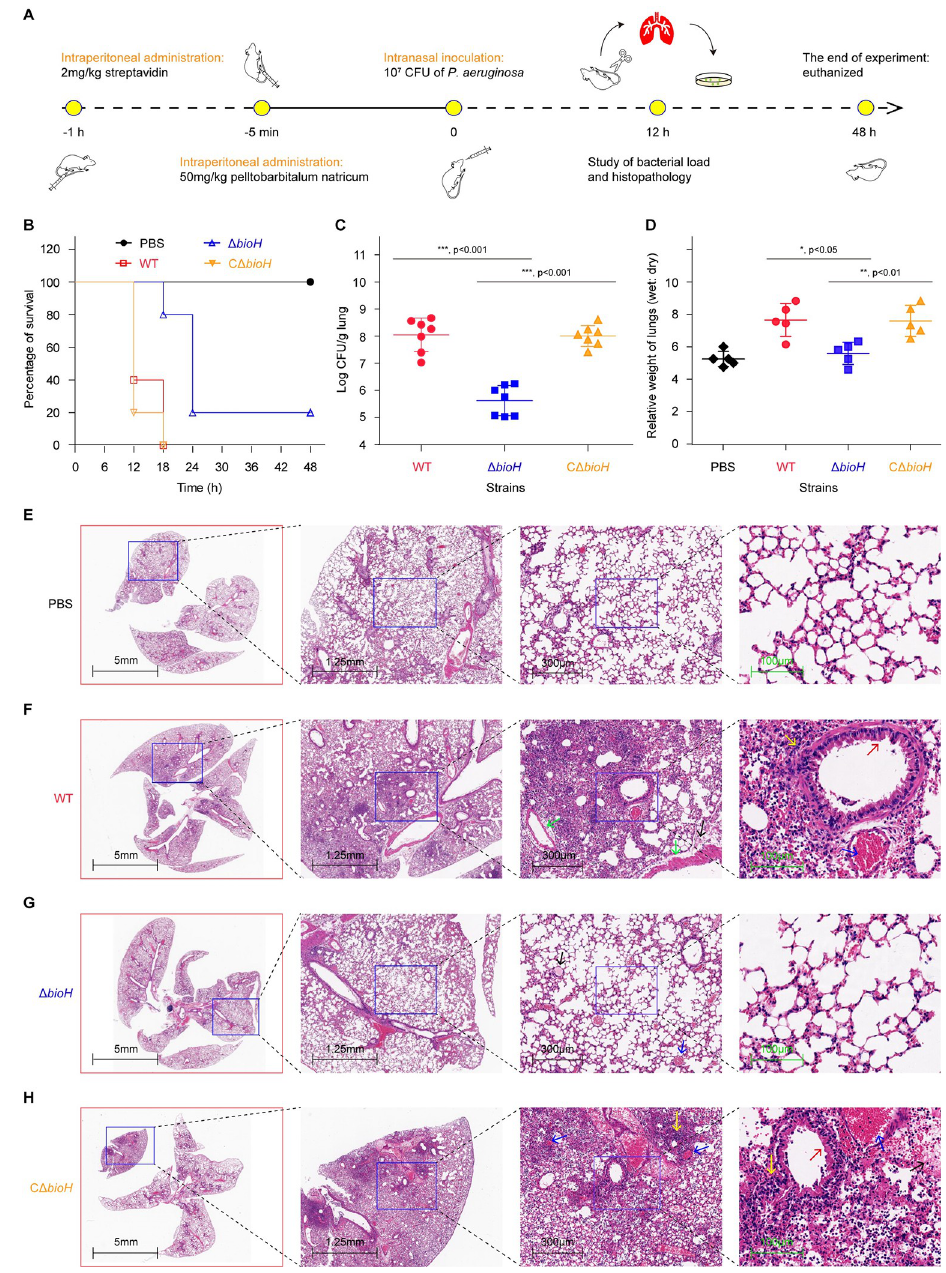
Fig 9. Intranasal infections of CD-1 mice elucidated that BioH (PA0502) plays a role in P . aeruginosa virulence. A. A strategy designed for mice challenge with P . aeruginosa via an intranasal administration. As described in Fig 8A, the cartoon models were generated by ourselves. B. Survival curves of CD-1 mice infected with various strains of P . aeruginosa . C. Bacterial load of the lung tissues from mice post-infection with three types of P . aeruginosa strains. D. Relative ratio (wet weight: dry weight) of the lung tissues from mice post-infection with three types of P . aeruginosa strains. Data are shown as means ± SD, and were analyzed in two-tailed way of variance via Mann Whitney test. Representative histopathology of the lung tissue from mice inoculated with the blank control PBS ( E ) and the positive control, wild-type strain PAO1 of P . aeruginosa ( F ). G. Pathological section of the lung tissue from mice infected with the Δ bioH mutant of P . aeruginosa PAO1. H. Histopathological analyses of the lung tissues collected from mice challenged with the complemented strain (C Δ bioH ) of the P . aeruginosa Δ bioH mutant. The lung tissues were collected from infected and placebo mice, which were killed and necropsied on 2 dpi. Lung samples were stored in formalin for 7 days and subsequently embedded in paraffin. Finally, hematoxylin and eosin were applied in staining of sectioned samples. PBS denotes the blank control group, and WT is the positive control group. Scale bars are labeled on